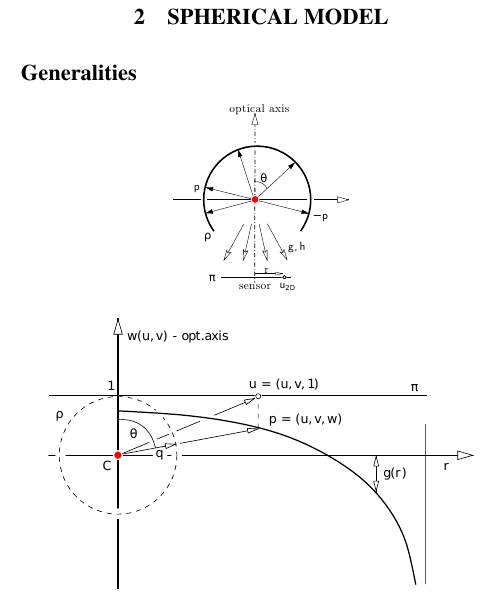
Figure 1: Spherical representation of a Fisheye lens mo- del (Miˇcuˇs`ık,